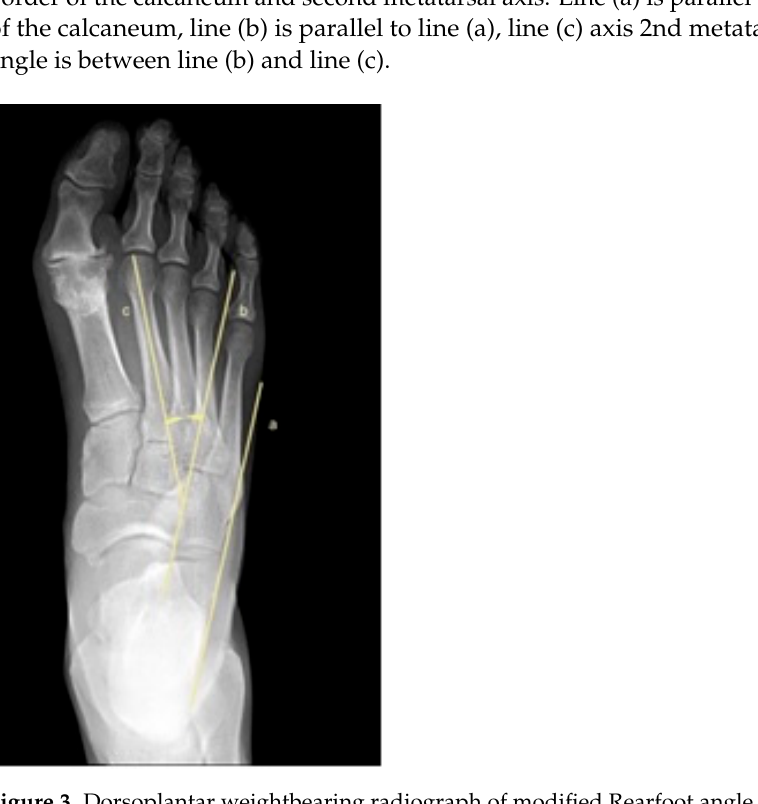
Figure 3. Dorsoplantar weightbearing radiograph of modified Rearfoot angle.